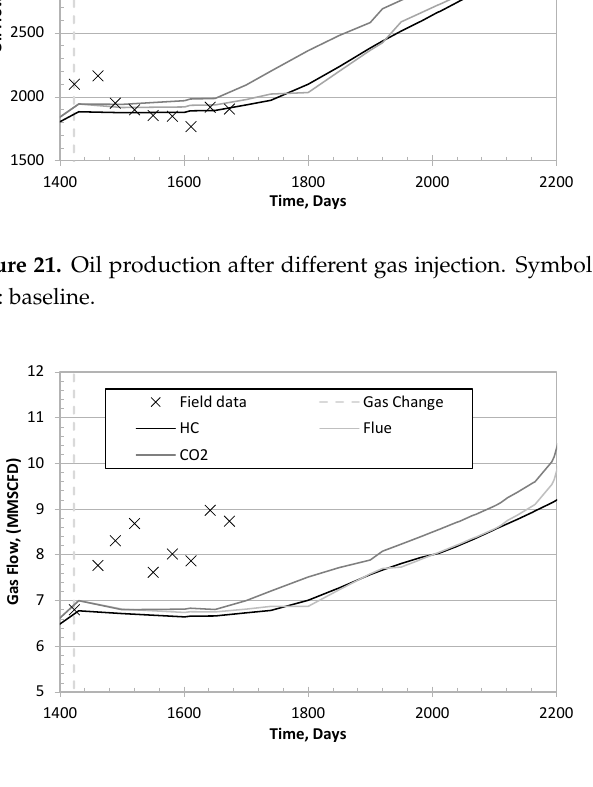
Figure 22. Gas production after different gas injection. Symbols: field measurements; continuous line: